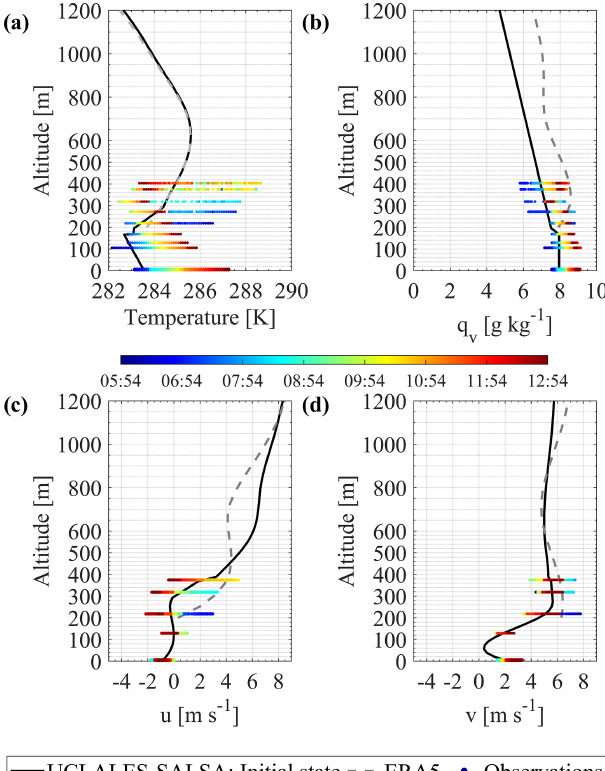
Figure 1. Vertical profiles used to initialize the simulation of case 1, diurnal cloud event of 24 September 2020 starting at 07:54 (UTC + 2 : 00). (a) Potential temperature, (b) specific humidity, (c) u component, and (d) v component of the horizontal wind veloc- ity. Each panel also shows local surface observational data from the Savilahti station, local vertical profiles observed at the Vehmasmäki station, and reanalysed data from ECMWF-ERA5